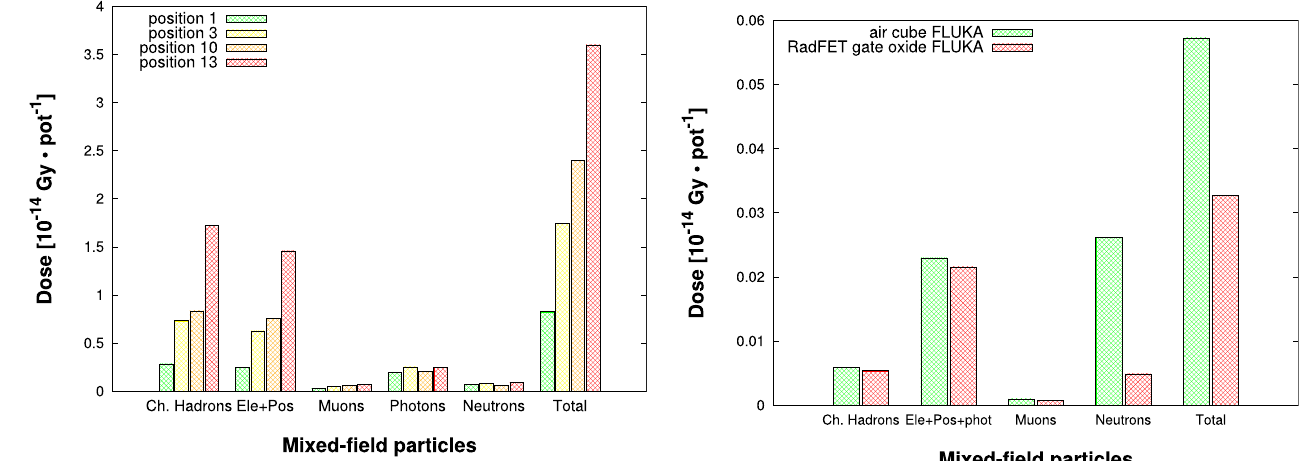
Fig. 7. Particles contribution to the total dose: dose values.